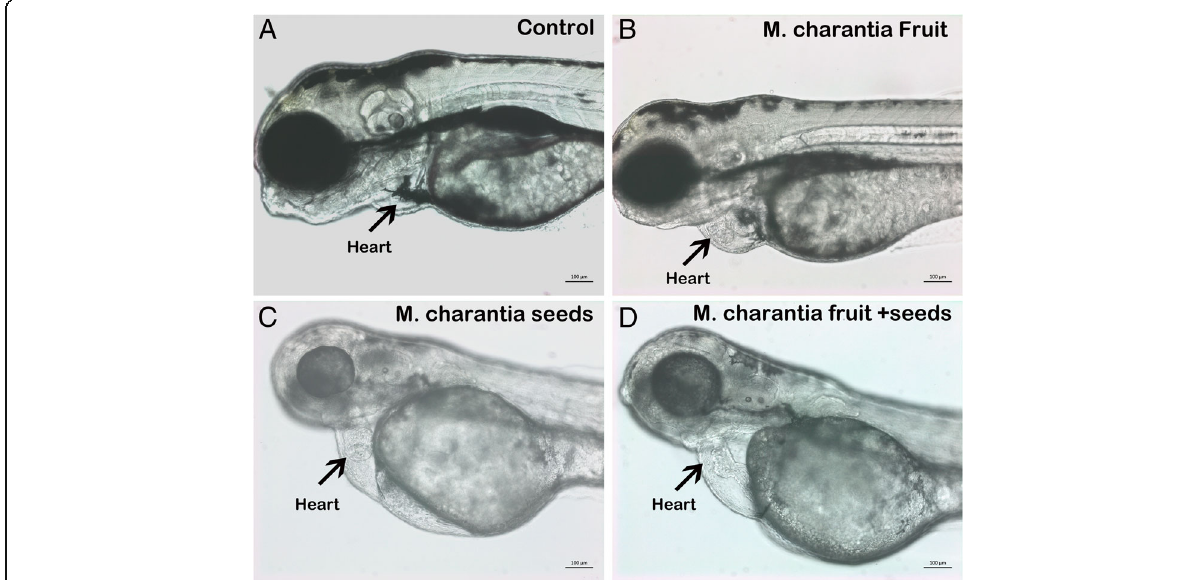
Fig. 6 The co exposure of fruit and seeds extracts of M. charantia resulted lethality and severe cardiac toxicity in zebrafish embryos. Representative photomicrograph showing live zebrafish embryos at 3dpf control or treated with fruit, seeds or combination of seeds and fruit extract of M. charantia . a The mock (methanol 0.5%V/V) exposed embryos did develop normally and had normal heart growth and development. b The zebrafish embryos treated with fruit extract (100 μ g/ml) had severe cardiac hypertrophy, c the embryos treated with 15 μ g/ml of seeds extract had cardiac hypertrophy and also enlarged cardiac cavity. d The embryos which were treated with combination of both extract showed severe effect on heart formation as fused ventricle and atrium represented as string and also enlarged heart